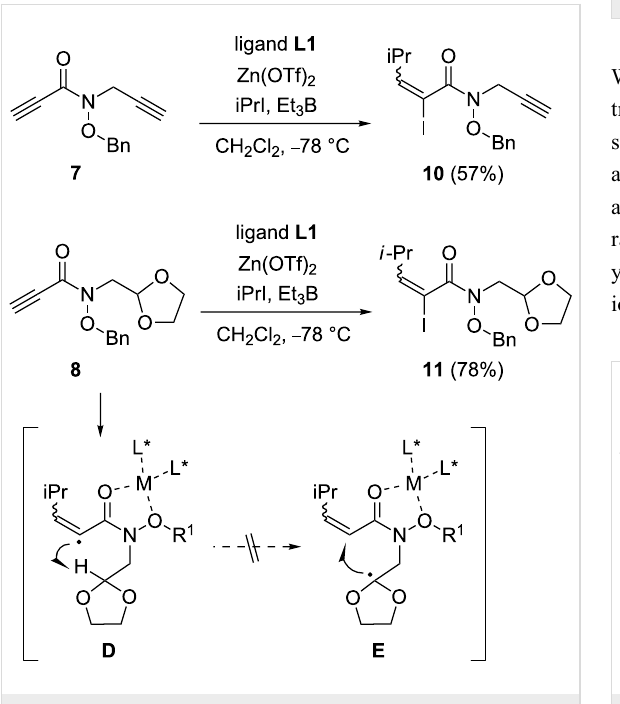
Scheme 4: Reaction of propiolic acid derivatives 7 and 8